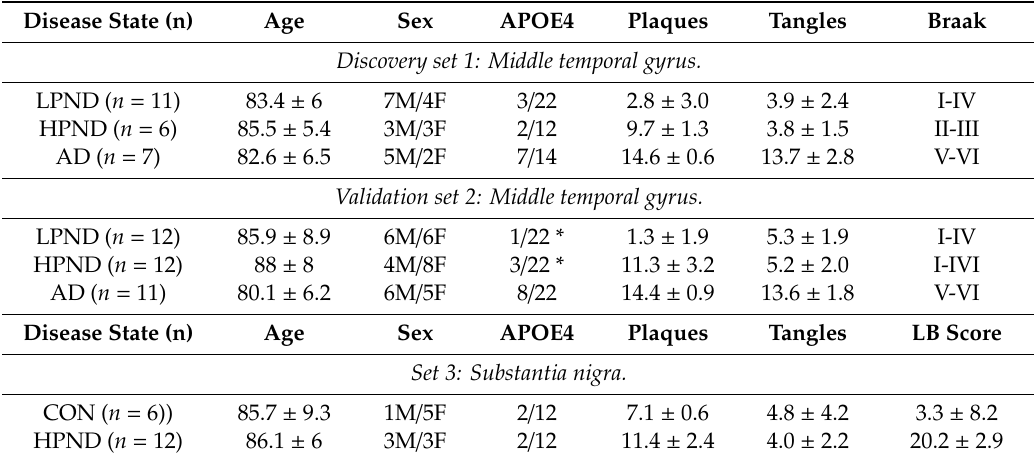
Table 1. Demographic Details of Human Brain Cases